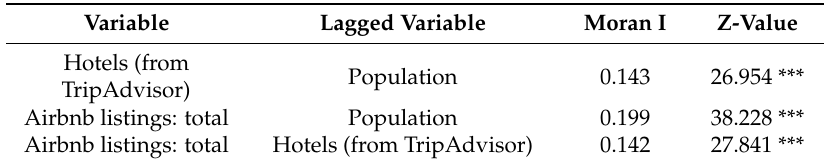
Table 5. Values of bivariate global Moran I.